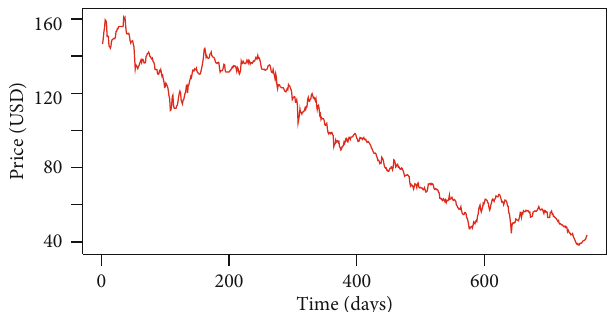
Figure 2: Daily price of steel from 2013 to